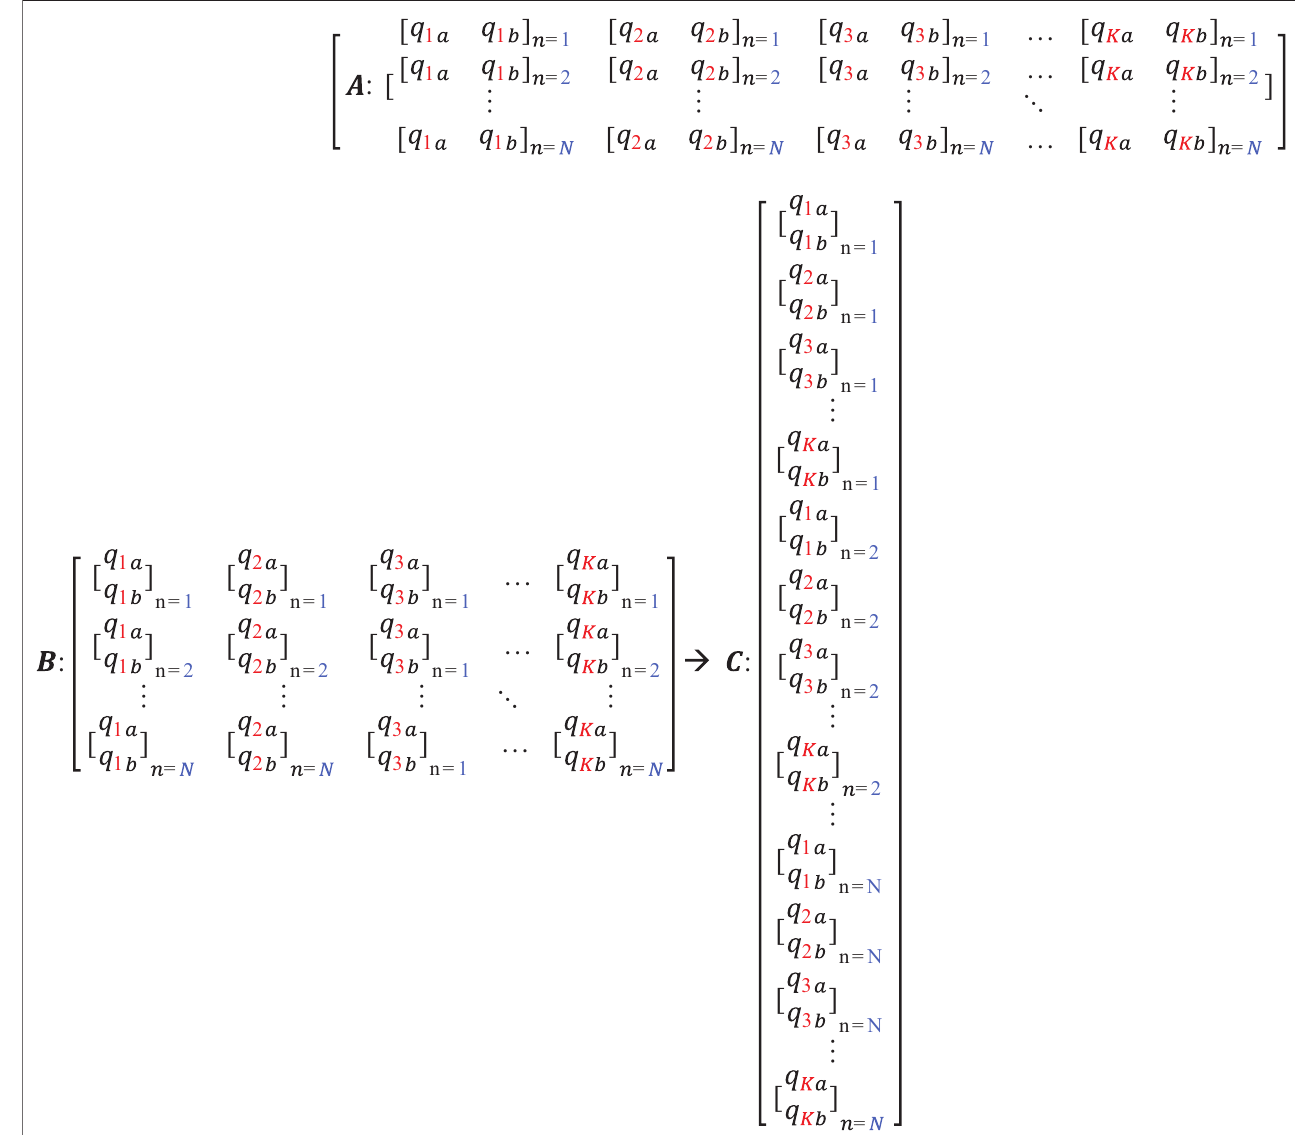
FIGURE 1-A1: Example of reshaping